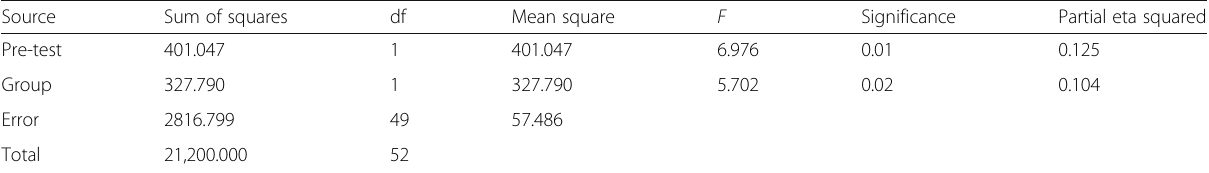
Table 4 Result for understanding/perspective taking assessment between the two intervention groups Source Sum of squares df Mean square F